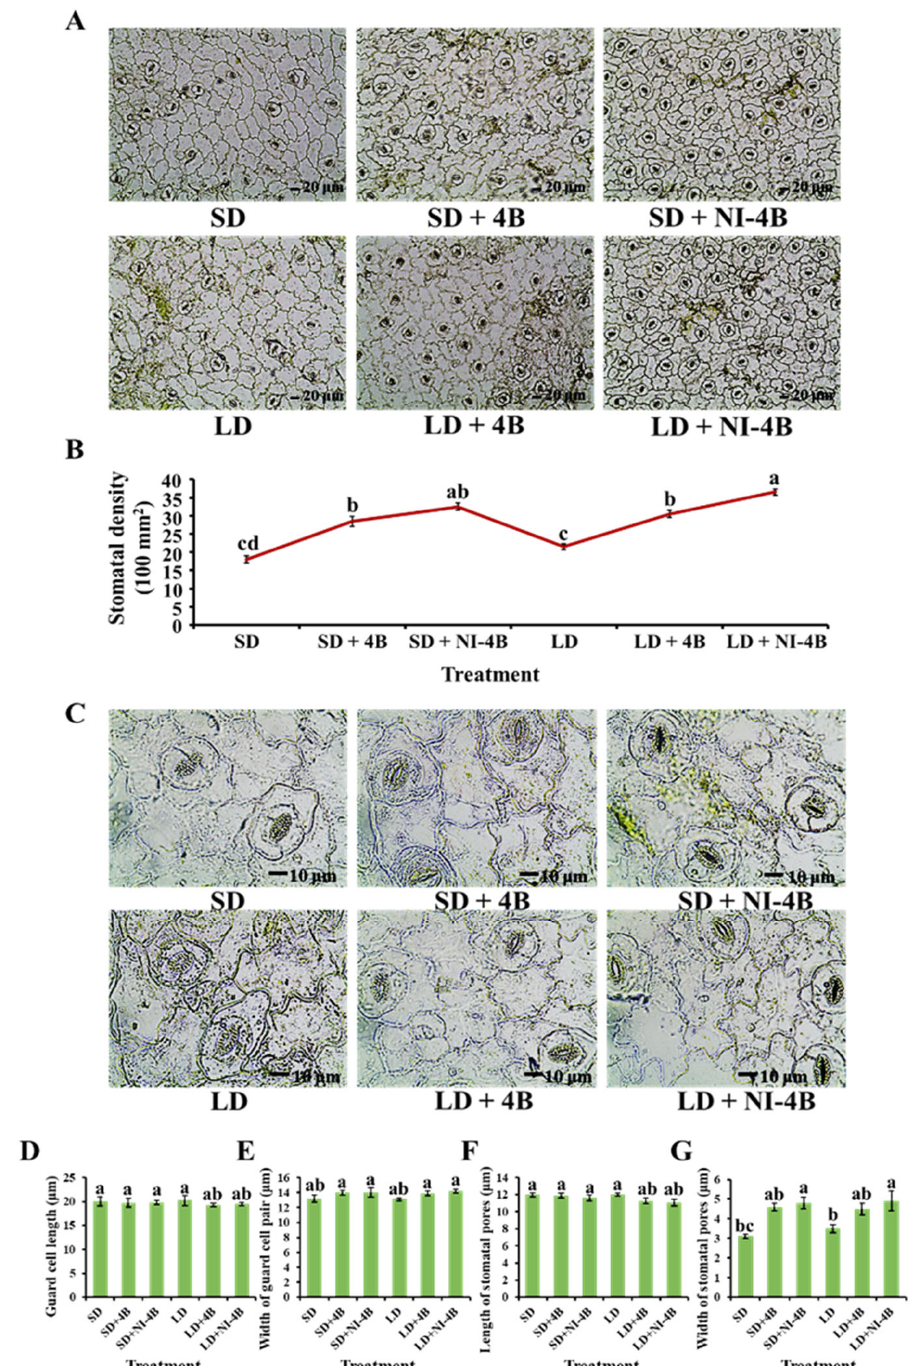
Figure 5. The effects of the supplementary and night-interrupting 10 µ mol · m − 2 · s − 1 PPFD B light on the stomatal parameters of kalanchoe ( Kalanchoe blossfeldiana ‘Rudak’) leaves, after 60 days of exposure to the photoperiodic light treatments: The stomatal density ( A , B ) (10 × enlargements); the length and width of guard cells and stomatal pores ( C – G ) (40 × enlargements). Bars indicate 10 µ m. Vertical bars indicate the means ± standard error ( n = 6). Different lowercase letters indicate significant separation within treatments by Duncan’s multiple range test at p ≤ 0.05. (See Figure 2 for details on the photoperiodic treatments with B light).